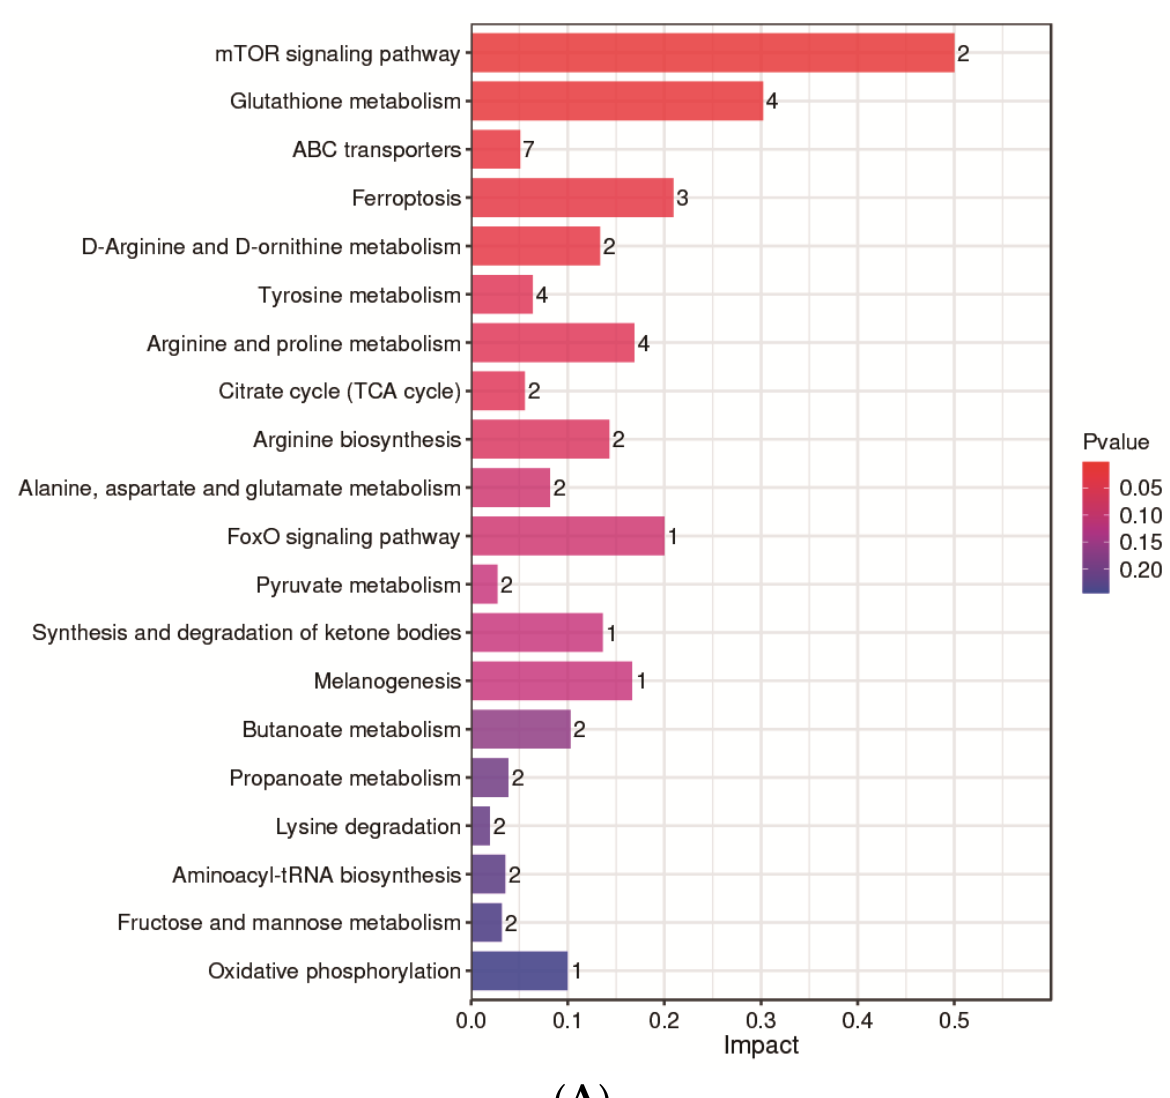
( B ) Figure 6. ( A ) KEGG analysis histogram of differentially expressed metabolites. Twenty metabolic pathways were identified based on the p -values. Impact values represent the contributions of me- tabolites detected for these pathways. The higher the impact value, the higher the contribution rate of the metabolites enriched in the pathway. ( B ) The results of untargeted metabolomics on